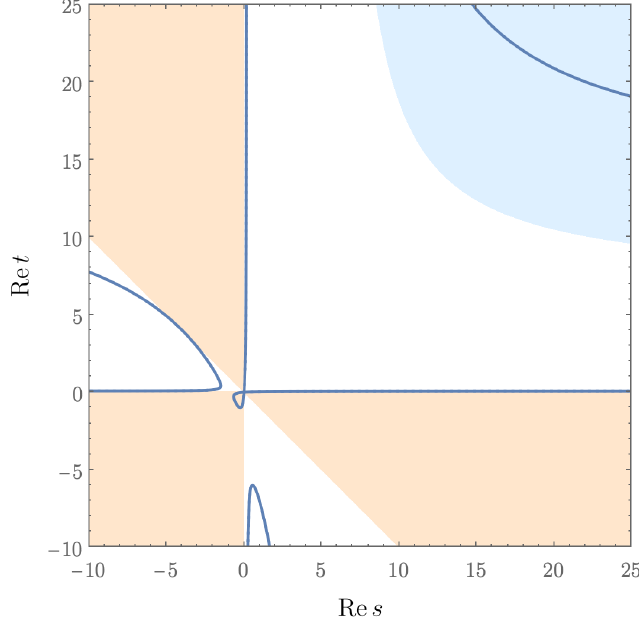
Figure 23: Four branches of the box Landau singularity (5.10) with ⃗ n = ( 1,3,2,4 ) in blue. Physical regions are shown in orange, while the region carved out by imposing positivity of ⃗α ∗ from (5.12) is contained in s , t ⩾ 0 and plotted in blue. This illustrates that only one branch of the box anomalous threshold lies on the physical sheet, though not in any physical